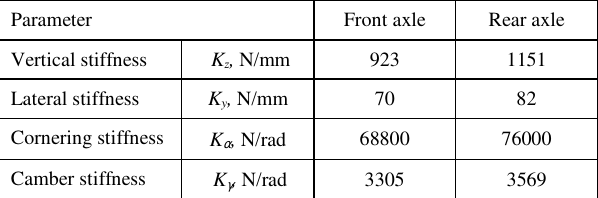
Table 2. The stiffness of tire for full-dimensional vehicle determined on the basis of the tire of the physical model [own research]